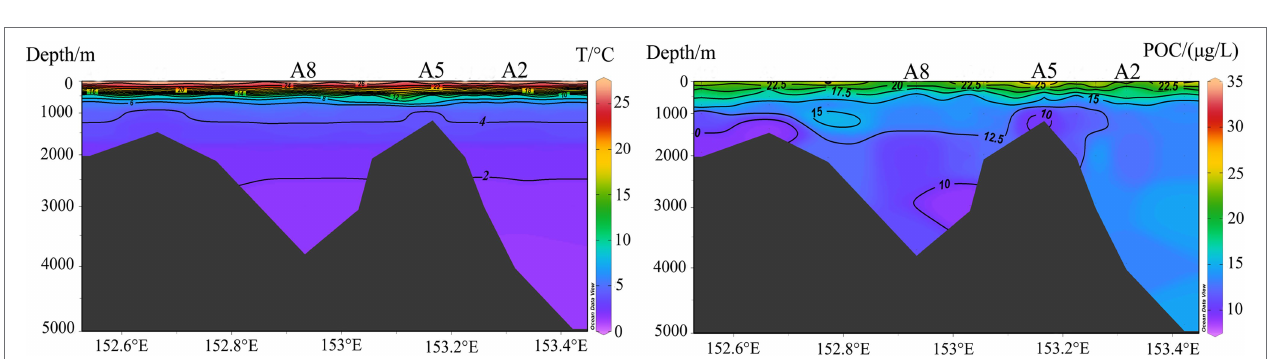
FIGURE 6 | Depth distribution of Antarctic Intermediate Water (AAIW), North Pacific Deep Water (NPDW), and Lower Circumpolar Water (LCPW) and their corresponding potential temperature and salinity in the surrounding area of the Kocebu Guyot. Mean temperature and salinity profiles over the measurement period are from a data assimilative global ocean analysis product (PSY4V3R1) created by Mercator Ocean. Other abbreviations: NPTW, North Pacific Tropical Water; NPIW, North Pacific Intermediate Water; and UCPW, Upper Circumpolar Water.